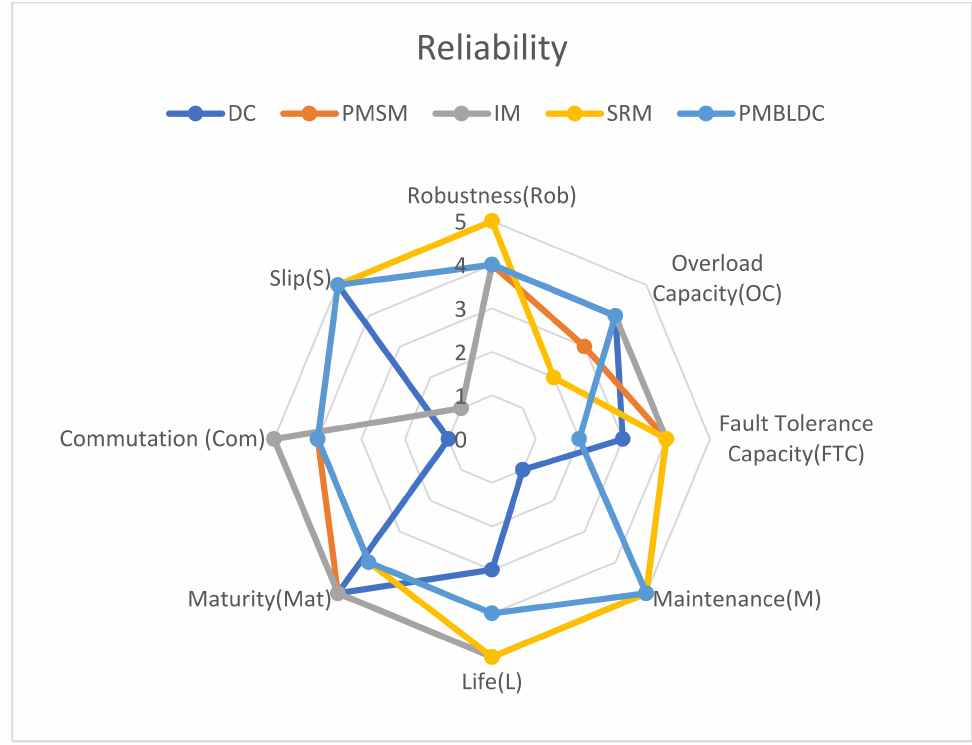
Figure 16. Factors related to the reliability of the electric motors for electric